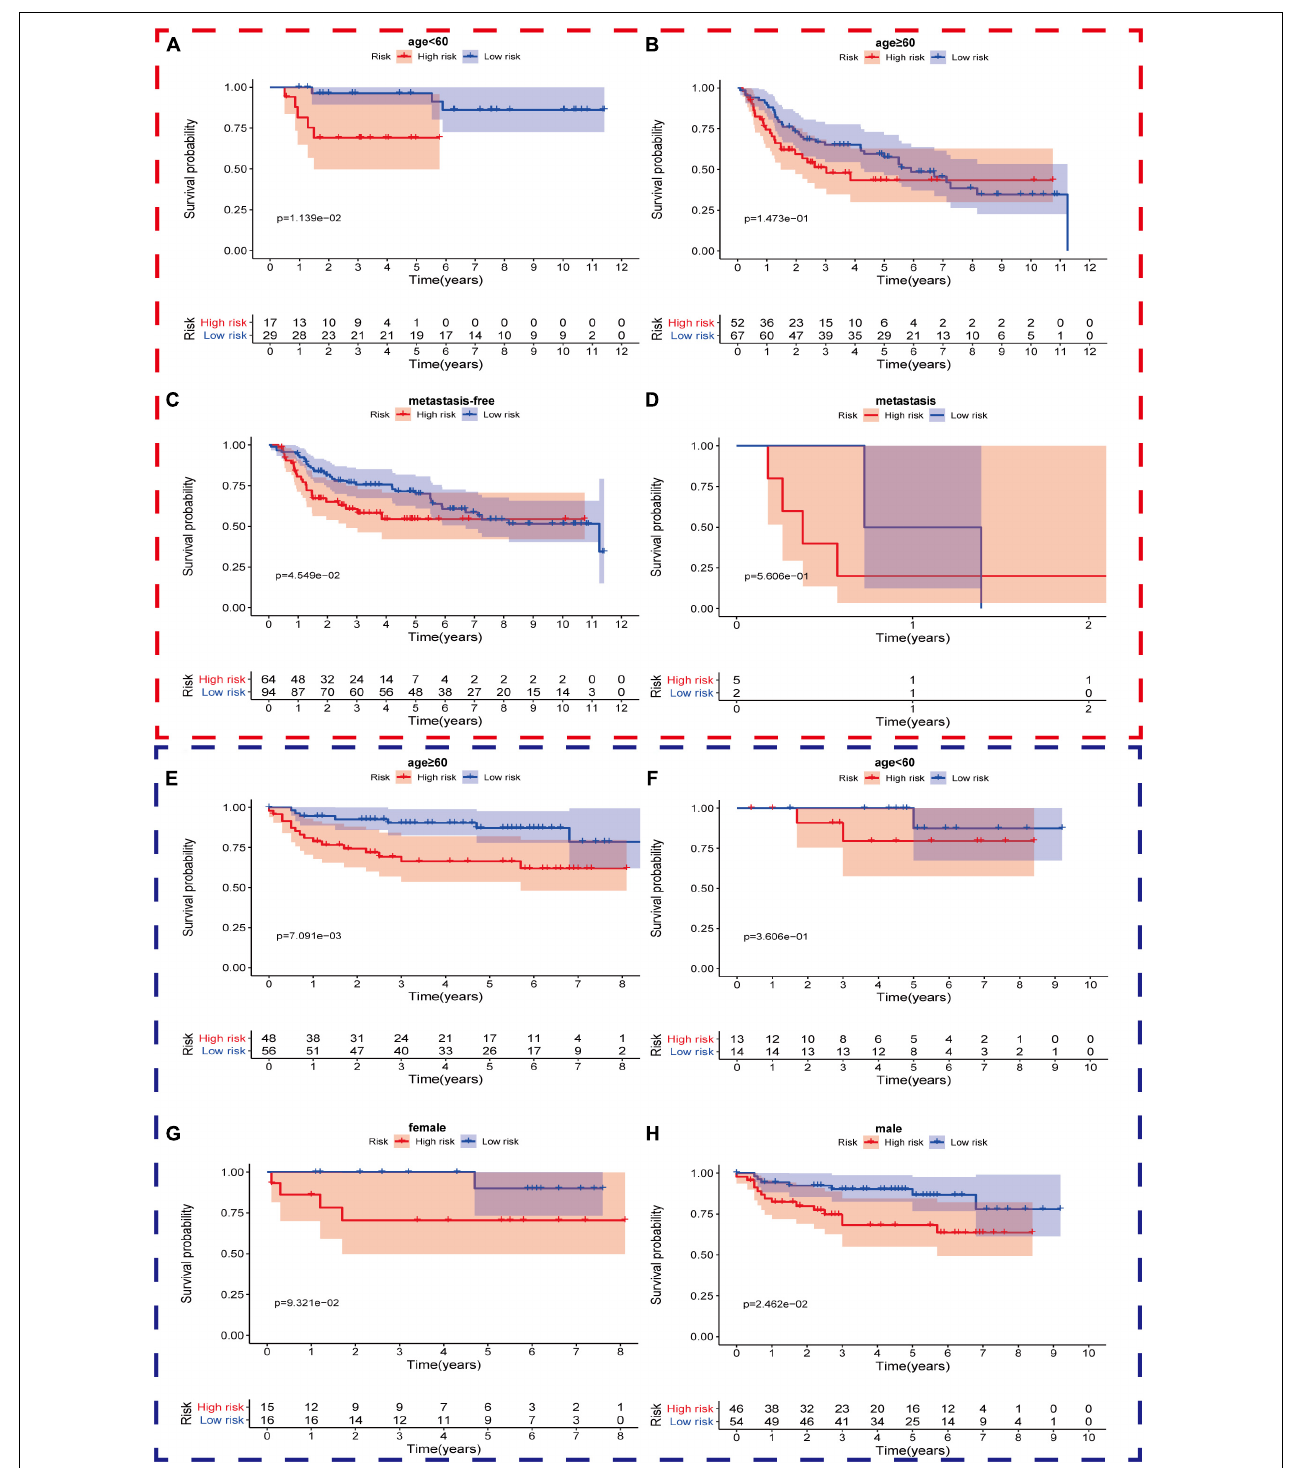
FIGURE 6 | The survival outcomes of bladder cancer patients with different risk scores in subgroups of (A) age < 60, (B) age ≥ 60, (C) metastasis-free, and (D) metastasis, in GSE13507, and subgroups of (E) age ≥ 60, (F) age < 60, (G) female, and (H) male, in GSE32548. The red and blue dashed boxes corresponded to the subgroups in GSE13507 and GSE32548, respectively. The survival times of the low risk group were significantly longer than those of the high-risk group in the subgroup of (A) age ≤ 60 and (C) metastasis-free in GSE13507, while the differences of overall survival time were significantly in subgroups of (E) age ≥ 60 and (H) male in